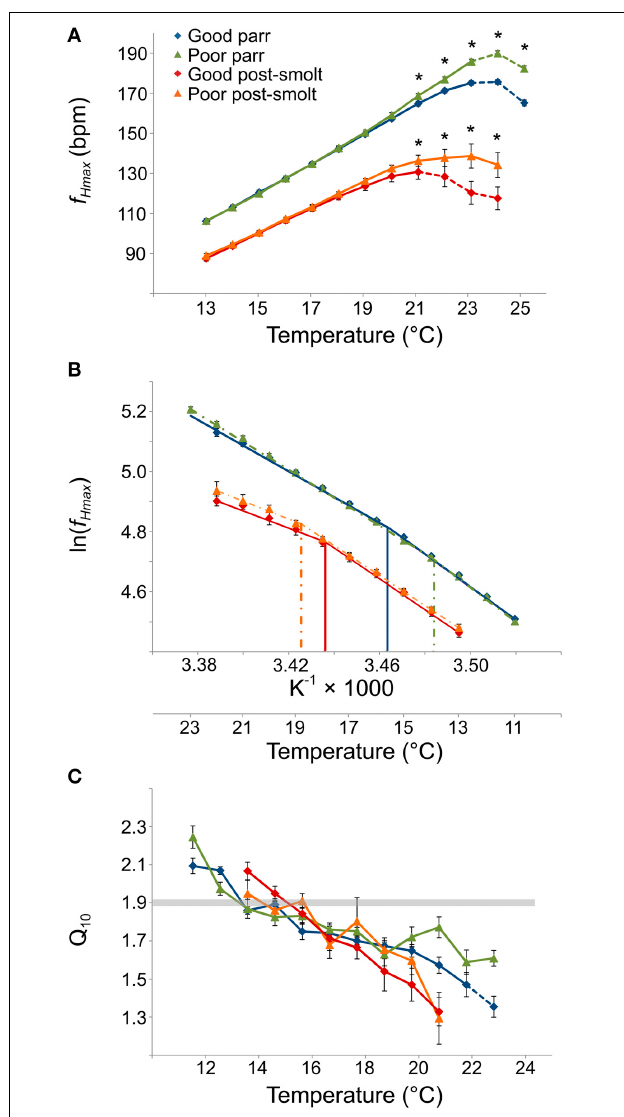
FIGURE 2 | (A) Maximum heart rates ( f Hmax ) ± S.E. of the swim capacity groupings during acute warming. ∗ indicates significant ( p < 0 . 05) difference between good and poor swimmers. The parrs had significantly higher heart rate in each temperature point than post-smolt ( F = 48, p < 0 . 05). The hatched line indicates the temperature where the first arrhythmias were observed. (B) Arrhenius plot of maximum heart rate ( f Hmax ) of good and poor swimmers. The vertical lines indicate an Arrhenius break point temperature (T AB ) for the swim capacity groupings. (C) Average Q 10 ± SE of maximum heart rate during acute warming. The gray bar (Q 10 = 1 . 9) indicates the rate transition temperature where maximum heart rate starts an abrupt reduction in its exponential dependence with temperature, which is the Q 10 break point temperature. In each figure, N = 12 per group for parr and N = 7 per group for